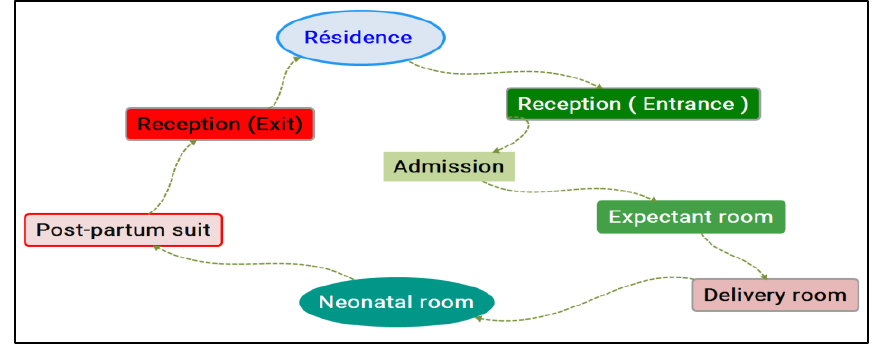
Figure 1. treatment path followed during the